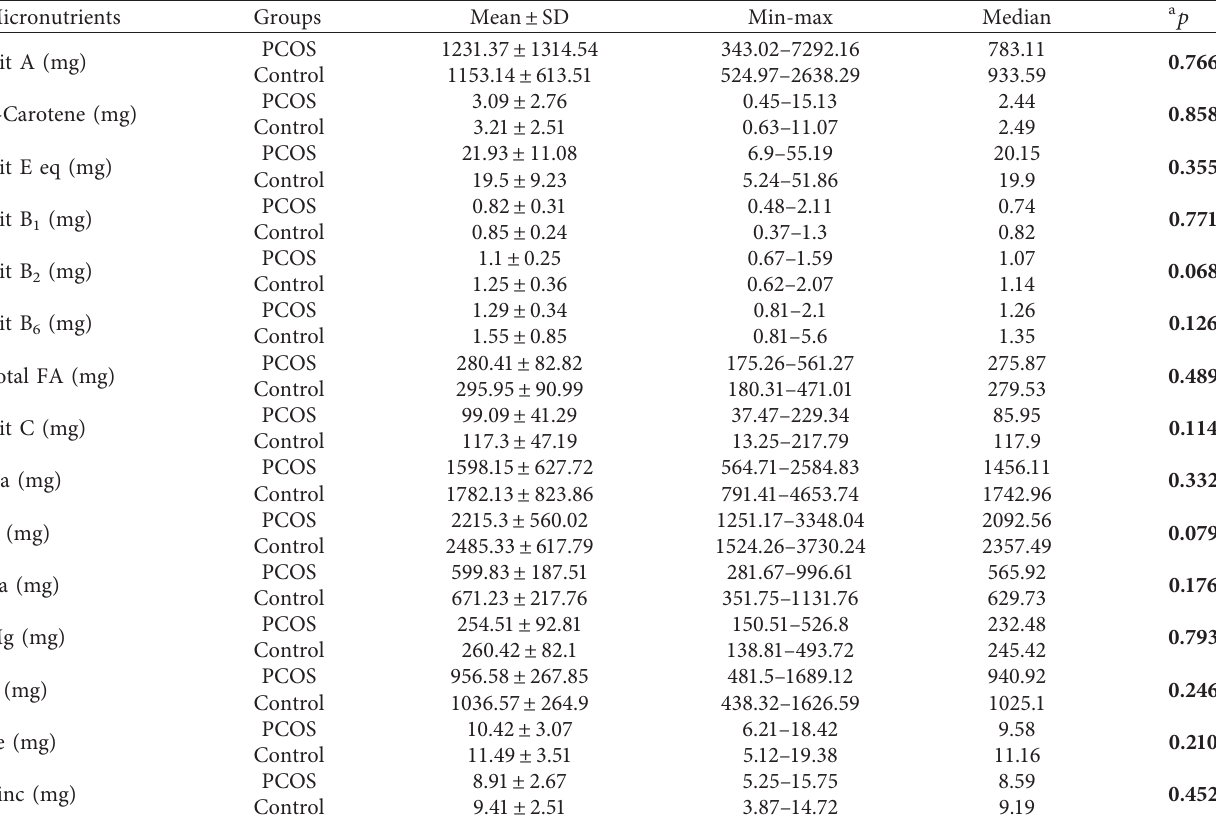
Table 6: Daily micronutrient composition of PCOS and